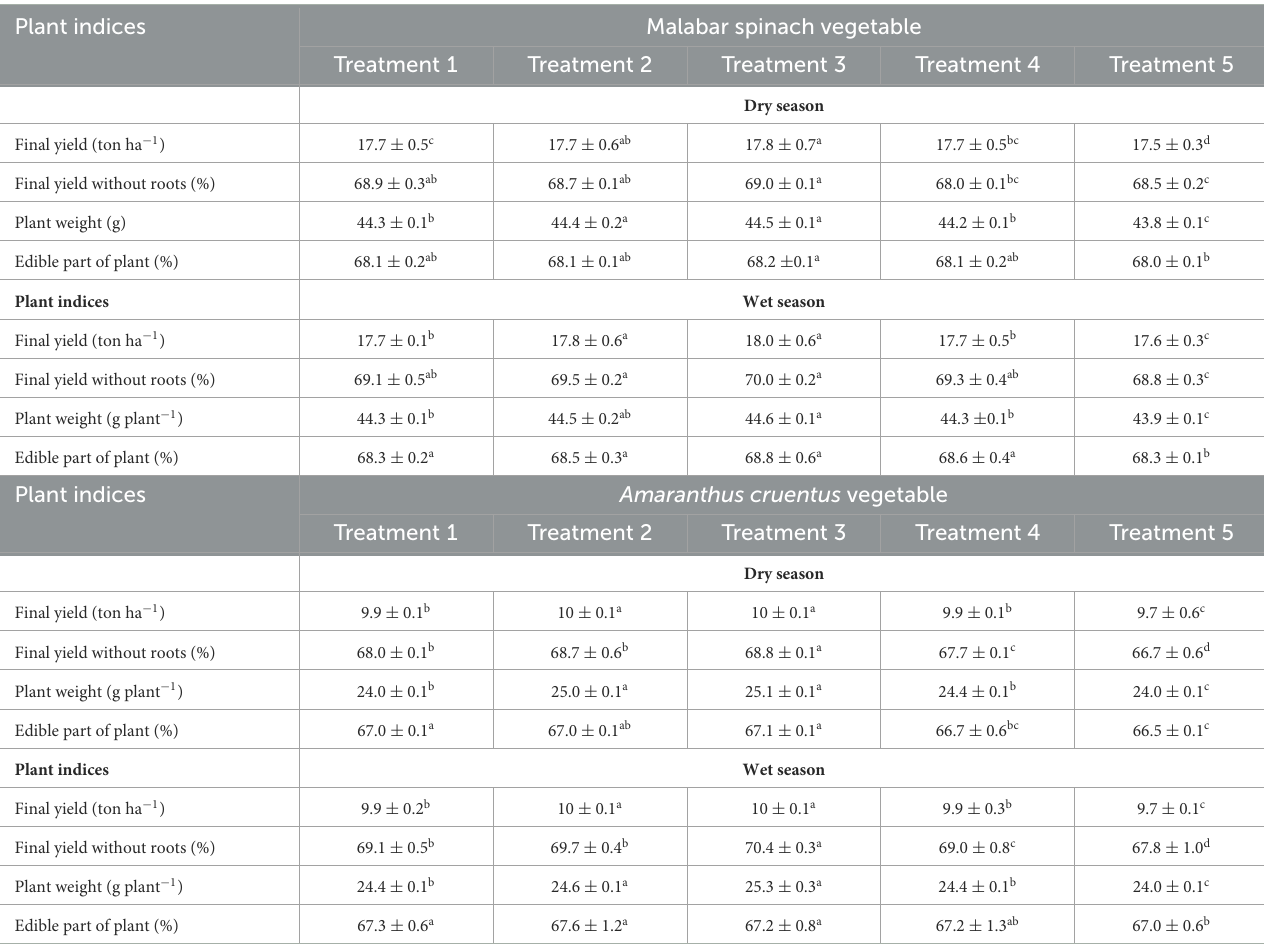
TABLE 5 Final yield and edible weight of Malabar spinach ( Basella alba L.) and Amaranthus cruentus ( Amaranthus L.) vegetables of each treatment in the dry and wet